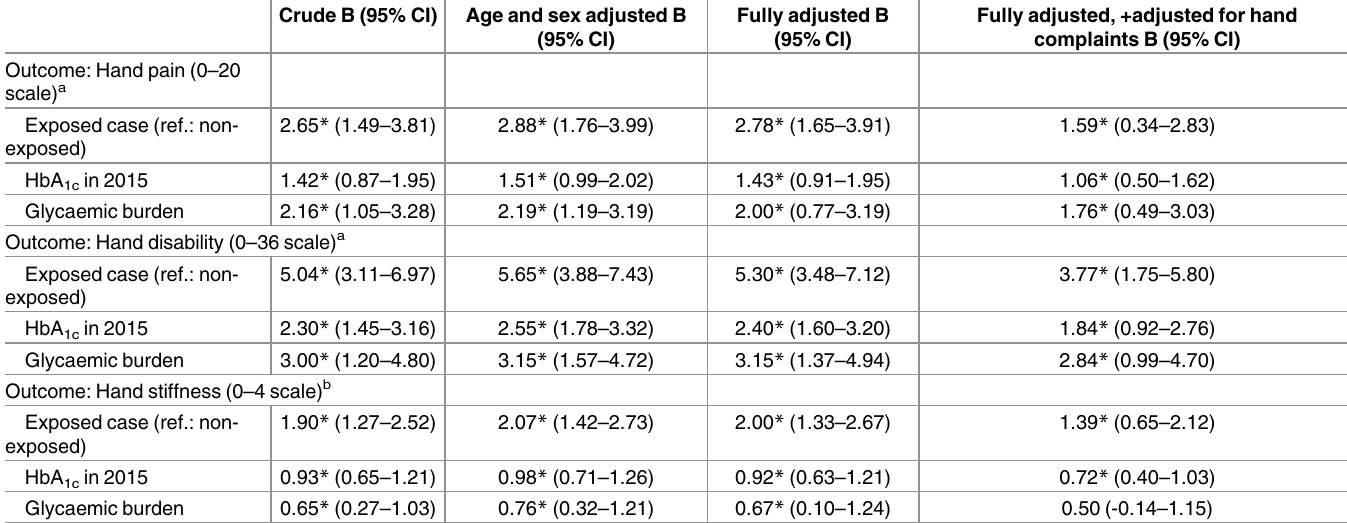
Table 3. Associations between case control status, HbA 1c and hand pain, function and